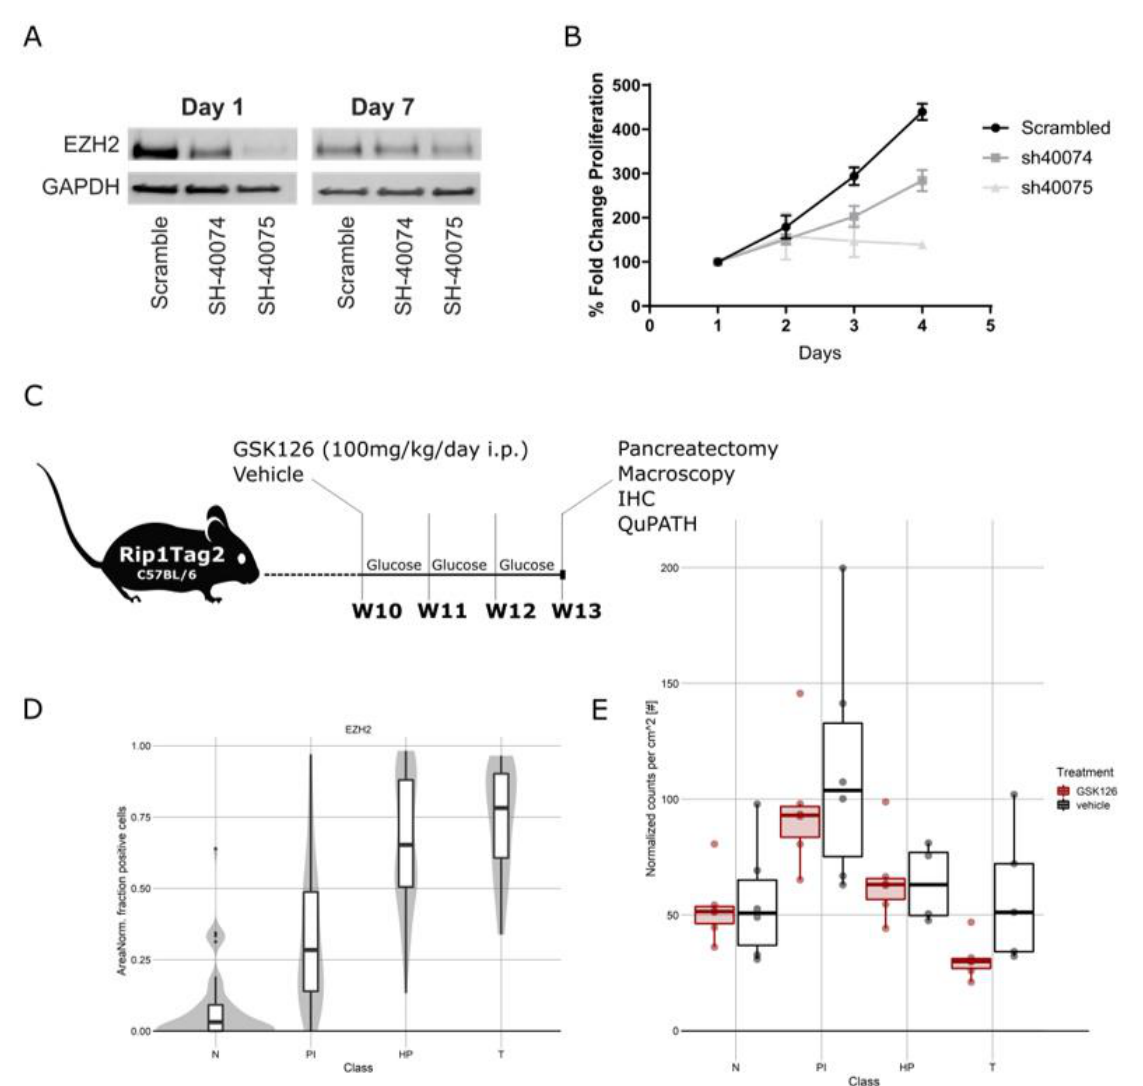
Figure 3. ( A ) Representative Western blot of EZH2 knockdown in QGP1 cells with SH40074, SH40075, and scrambled controls at 1 and 7 days after transduction. ( B ) Growth curve after transduction with SH40074, SH40075, and scrambled controls in QGP1. ( C ) Schematic representation of treatment of Rip1TAG2 mice. ( D ) EZH2 expression in Rip1TAG2 mice at different tumor stages: normal islet (N), proliferative islets (PI), hyperplastic islet (HP), and tumor (T). ( E ) Tumor burden in mice treated with EZH2 inhibitor and vehicle daily for 3 weeks from 10 weeks of age. Mice treated with EZH2 inhibitor presented a reduced tumor burden.